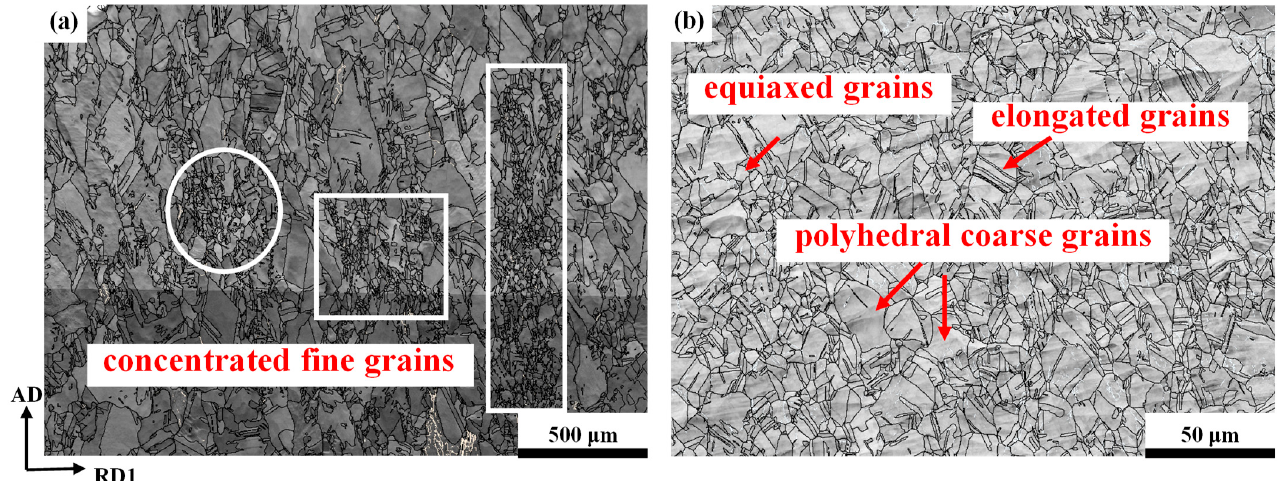
Figure 3. Superimposing with BC and GBs map for ( a ) HS-600 and ( b ) RS-25, respectively.